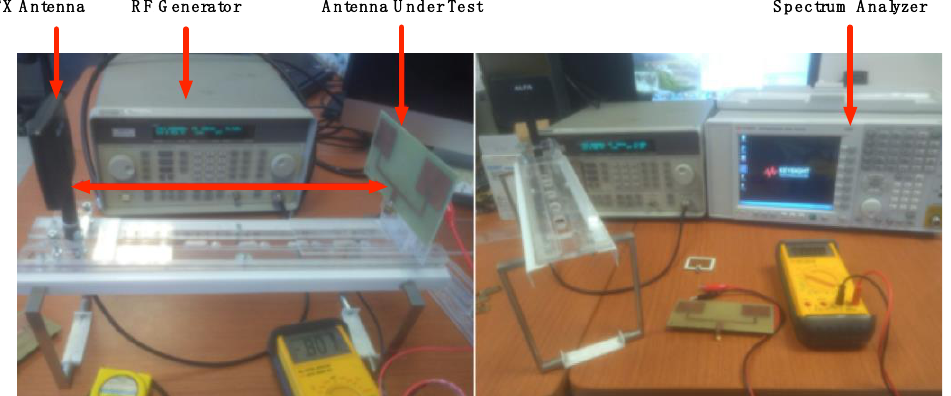
Figure 14. Testing with fixed power emission. Table 1. 2 × 1 Array gain